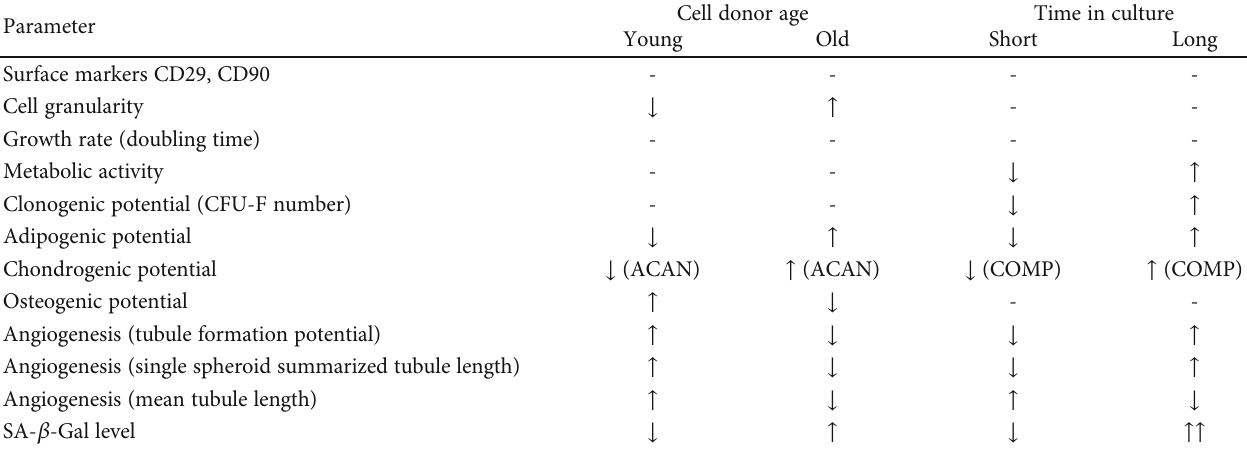
Table 2: Comparison of the ASC parameters analyzed in young versus old cell donors and in cells derived from short-term versus long-term cultures of ASCs. Descriptions: -: parameter similar in both groups, ↑ : parameter higher, or ↓ : lower than in corresponding group. ACAN and COMP — chondrogenesis marker genes, analyzed by real-time PCR. All the di ff erences are signi fi cant at least at p < 0 : 05 (detailed data in